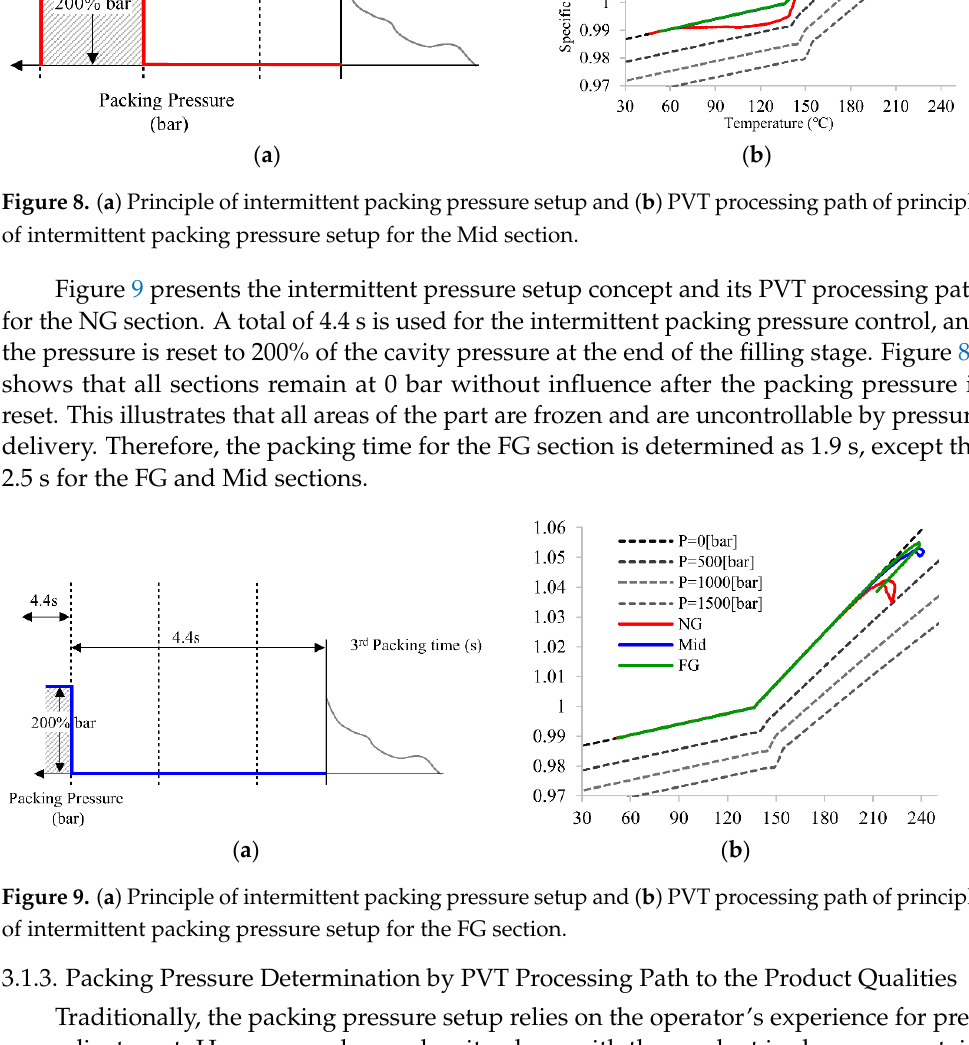
Table 2. Experimental parameters for packing pressure determination.